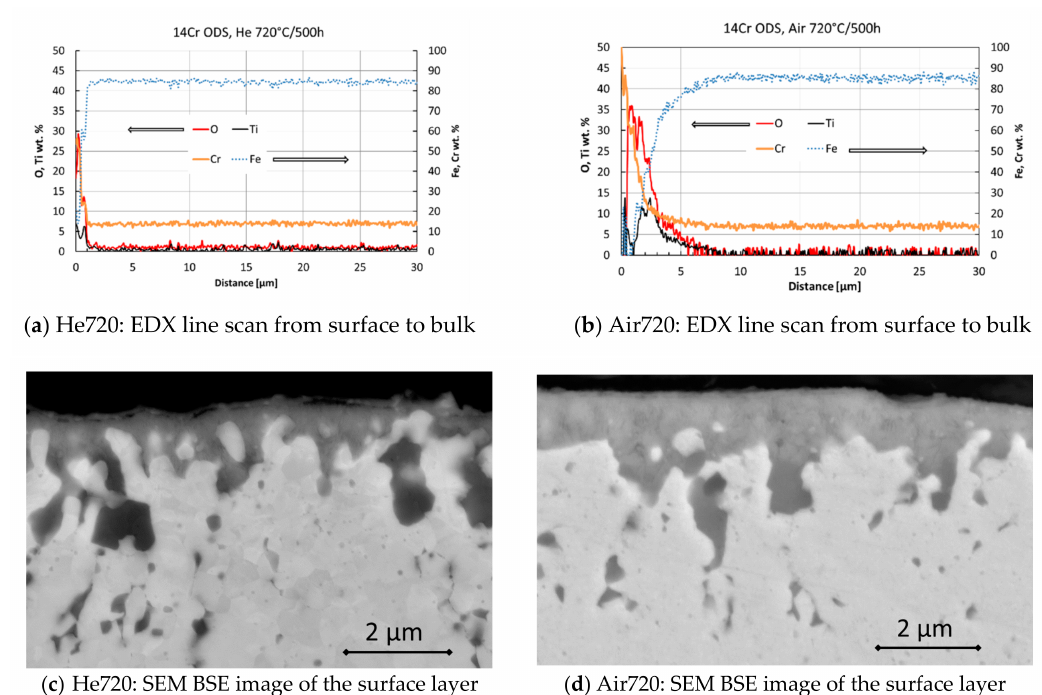
Figure 10. SEM-EDX line scans and BSE micrographs of the surface after the exposures at 720 ◦ C for 500 h in: ( a , c ) Helium; ( b , d ) air.